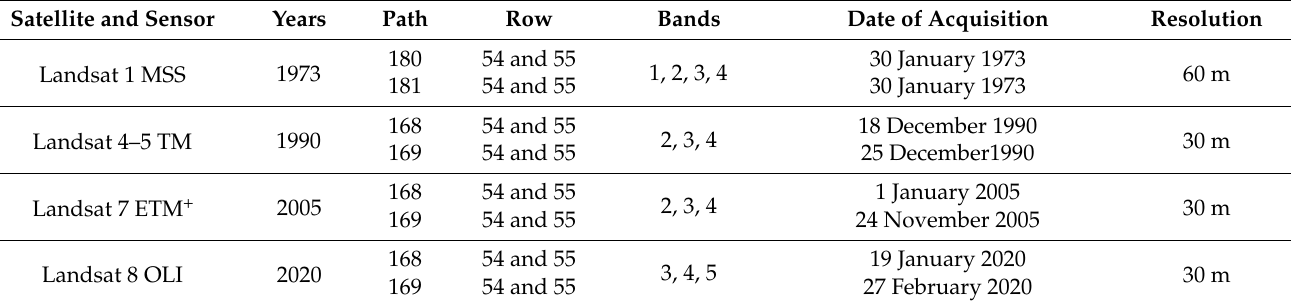
Table 1. Characteristics of the Landsat images used for the analysis of LULC changes. Satellite and Sensor Years Path Row Bands Date of Acquisition